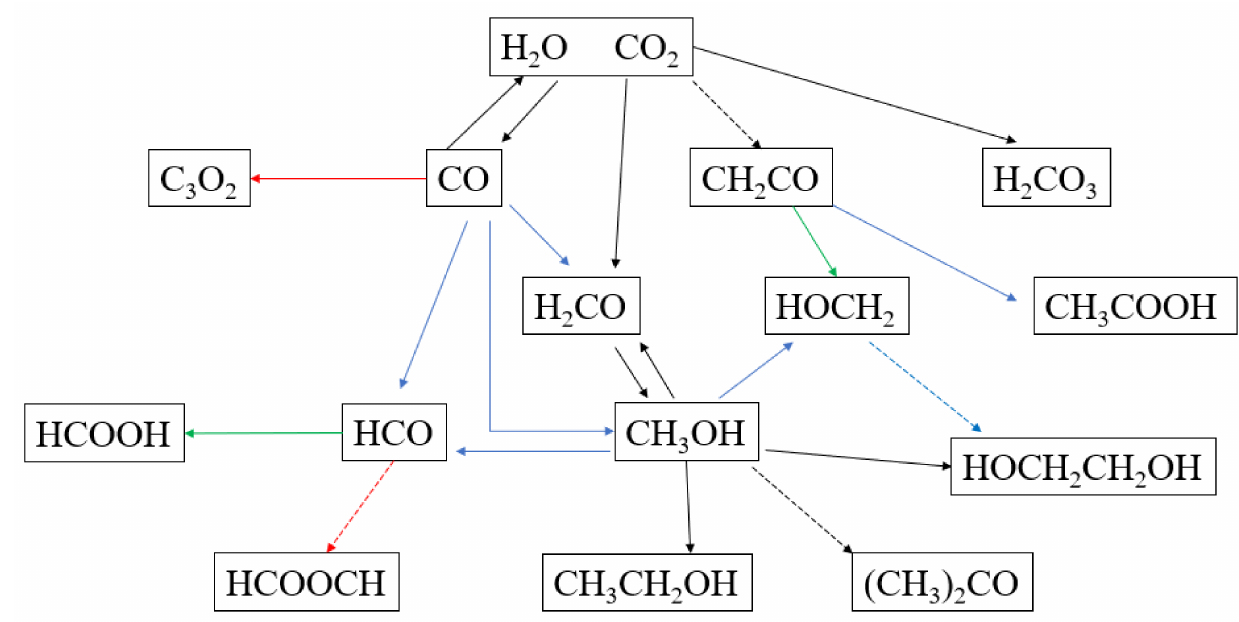
Figure 5. Potential reaction pathways (solid black lines) that occur in irradiated H 2 O-CO 2 ices, derived from laboratory experiments. Not all pathways are shown, and some pathways need to be re-evaluated by additional experimental research (dashed black lines). Figure adapted from [49]. Blue solid lines require the addition of H 2 O; red solid lines require the addition of CO; green solid lines (OH); red dashed lines (HCO); and blue dashed lines (HOCH 2 ). We note that although these species can be generated from H 2 O and CO 2 ices, other components present can also lead